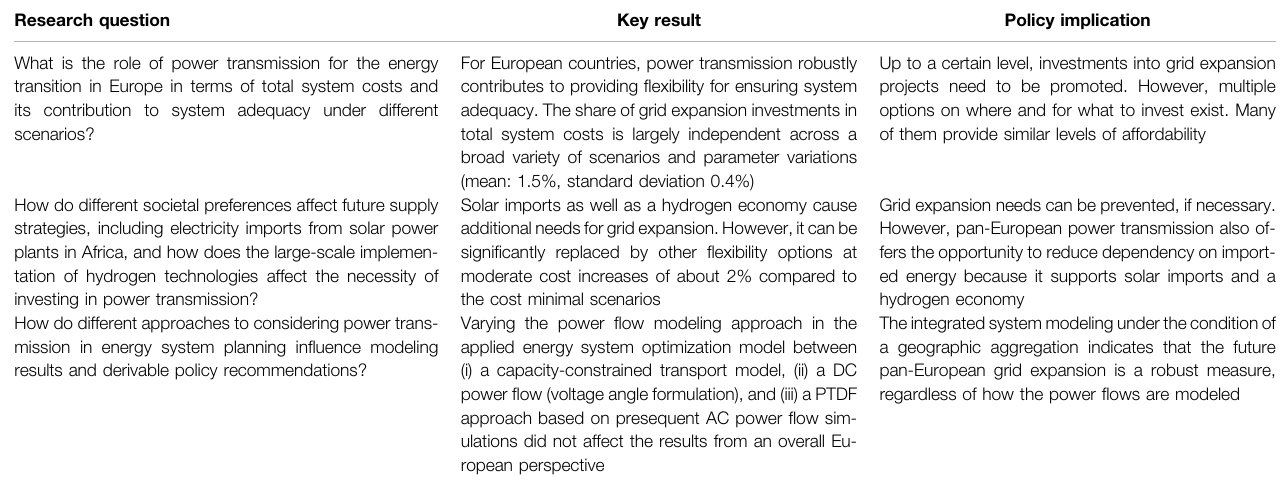
TABLE 5 | Research questions, key results, and policy implications of this